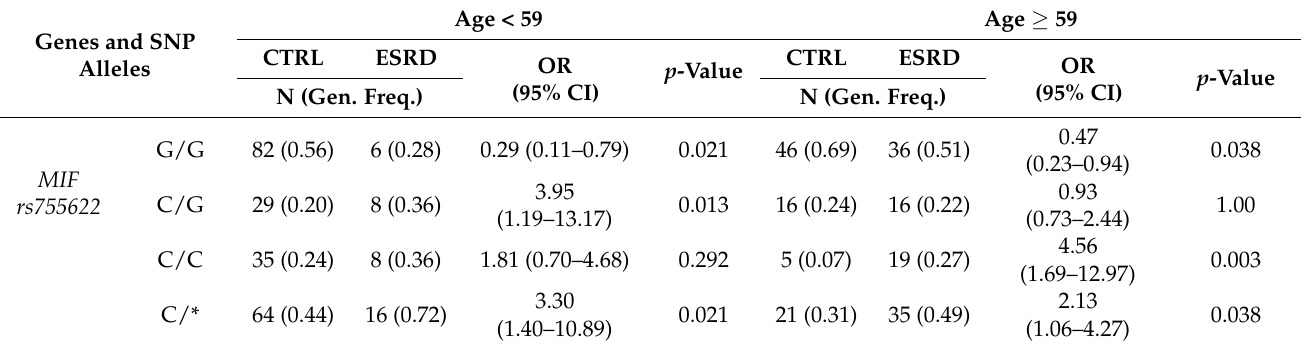
Table 5. Significant SNP genotype frequencies (gen. freq.) in end-stage renal disease patients (ESRD) and controls (CTRL) stratified according to 59 years age cut off (adjusted by gender, diabetes, hypertension, and